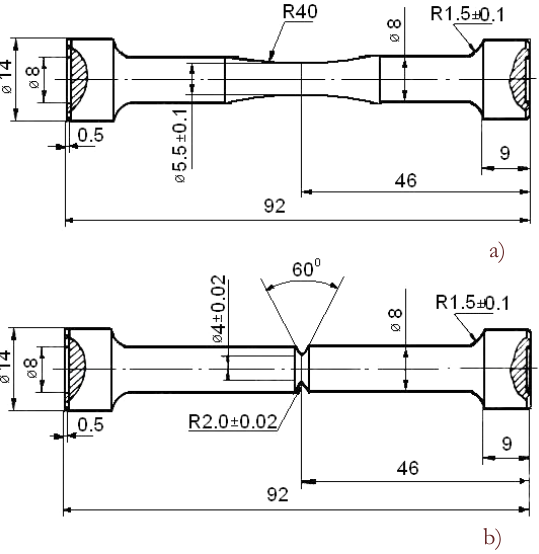
Figure 1. Schema of (a) smooth and (b) notched specimen, used in fatigue